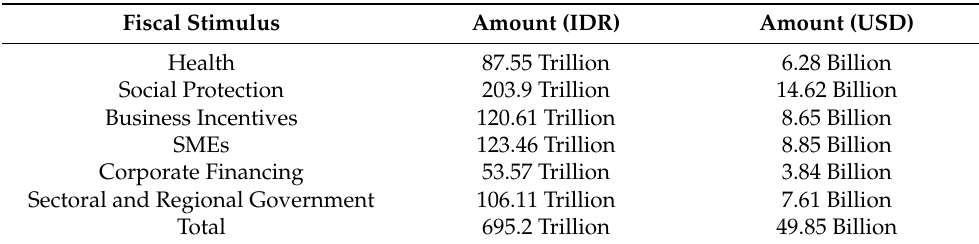
Figure 4. The timeline of COVID-19 mitigation policies (Modified from BAPPENAS [11]). Table 1. Indonesia’s fiscal stimulus against COVID-19 pandemic (Modified from Ministry of Fi- nance [51]).